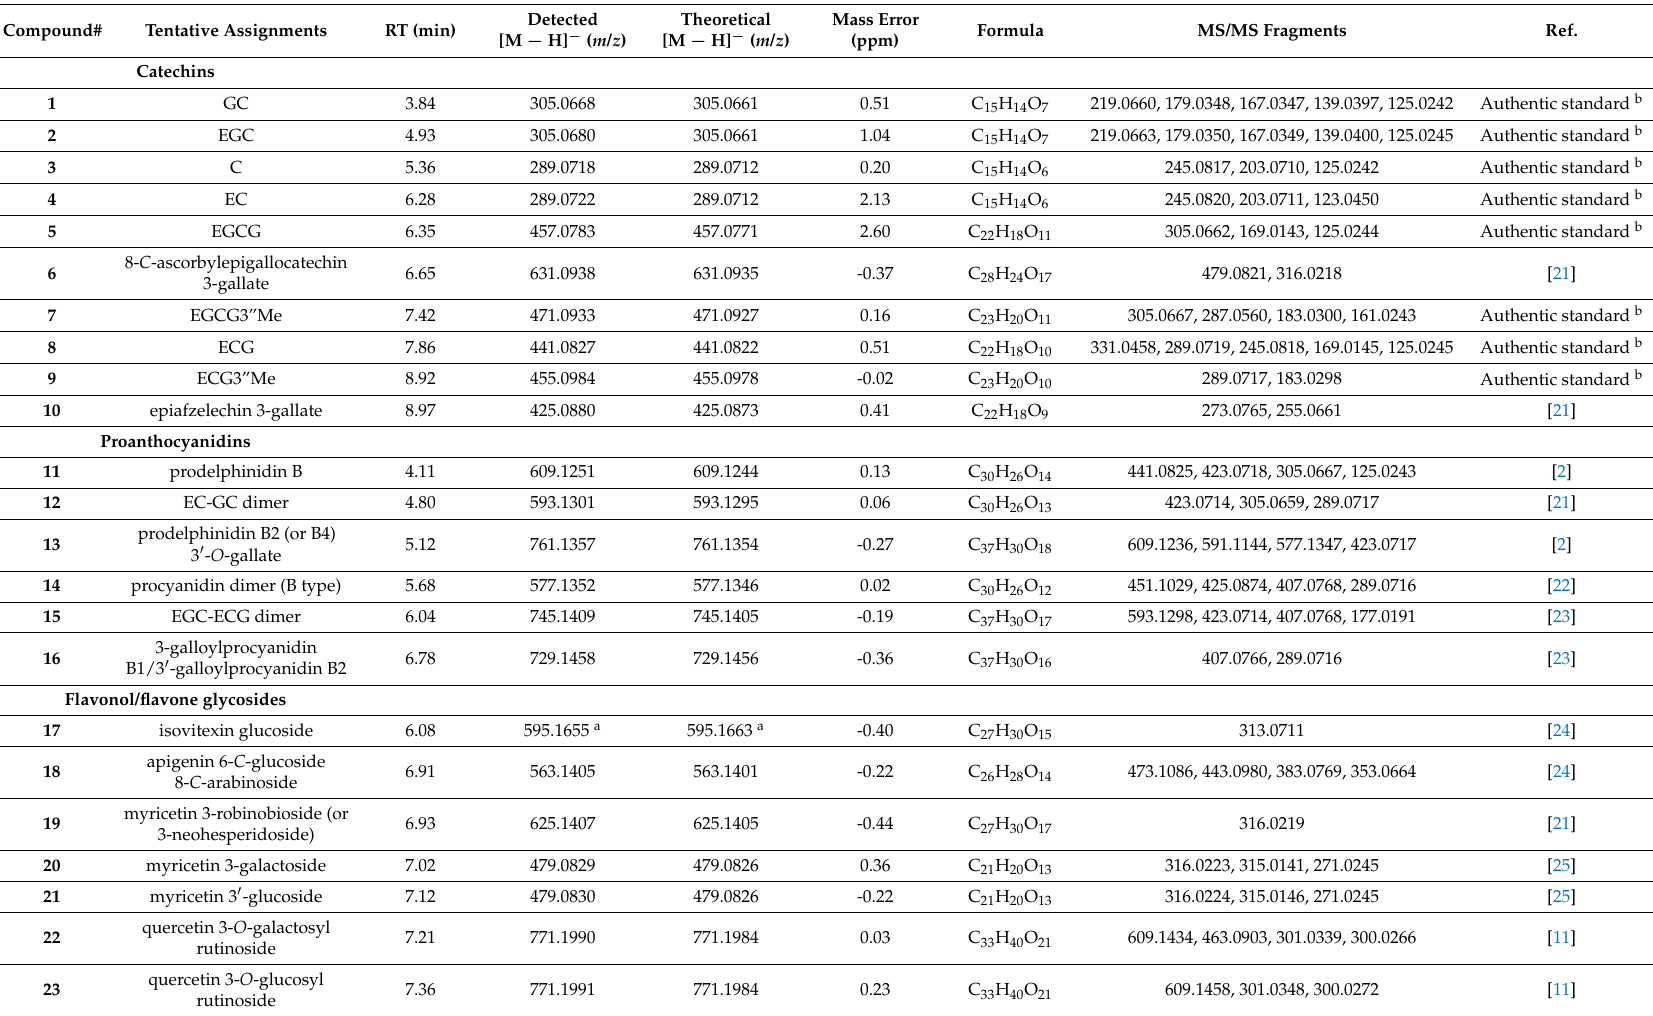
Table 1. Metabolites putatively identified in 14 tea cultivars by